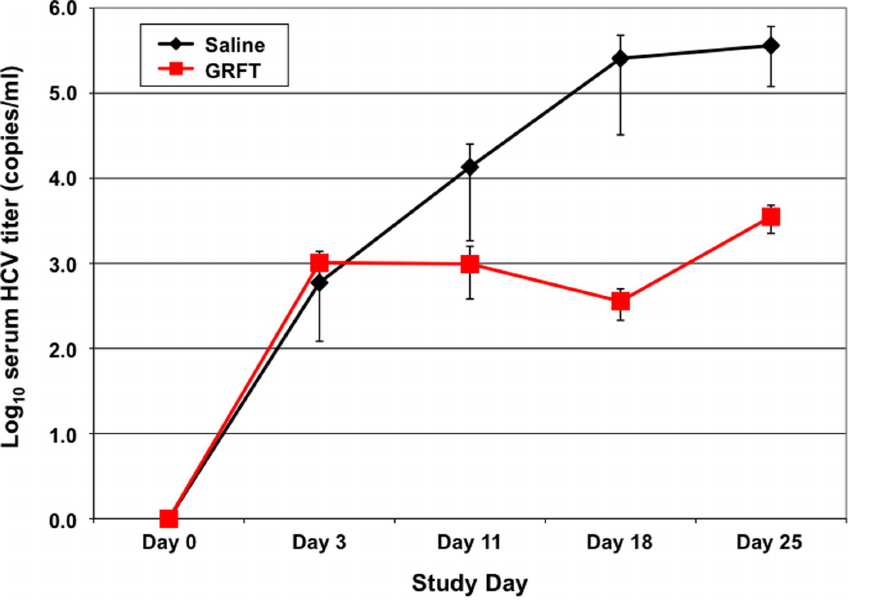
Figure 7. GRFT activity invivo at reducing viral titers after challenge with HCV. Serum HCV titer changes for saline control (black, n=6) and griffithsin treated (red, n=6) Alb-uPA/SCID transgenic mice engrafted with human hepatocytes during a 10-dvday treatment regimen. Error bars show the standard error for values at each time point. The minimum detectable limit of the virus load assay is 200 IU/ml.